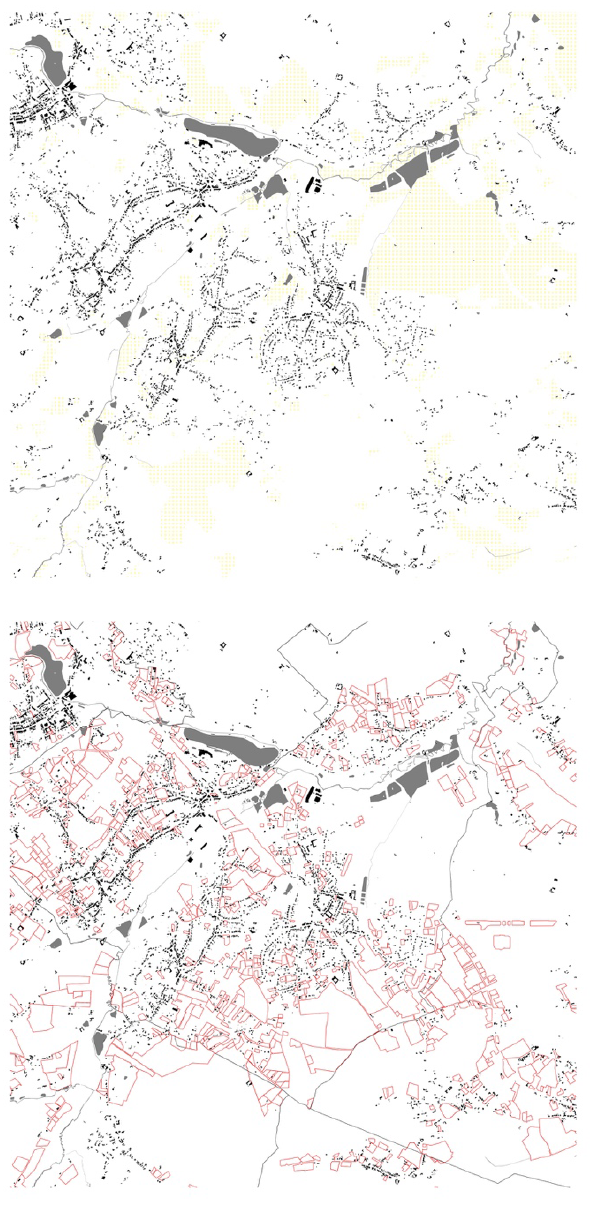
Figure 5. Map of Rixensart 1960 (left) and 2010 (right). Built elements (black), forest (yellow dots), water (grey), and allot- ments perimeter (red), municipal perimeter (dotted line). Elaborated by the author based on SPW-DG04